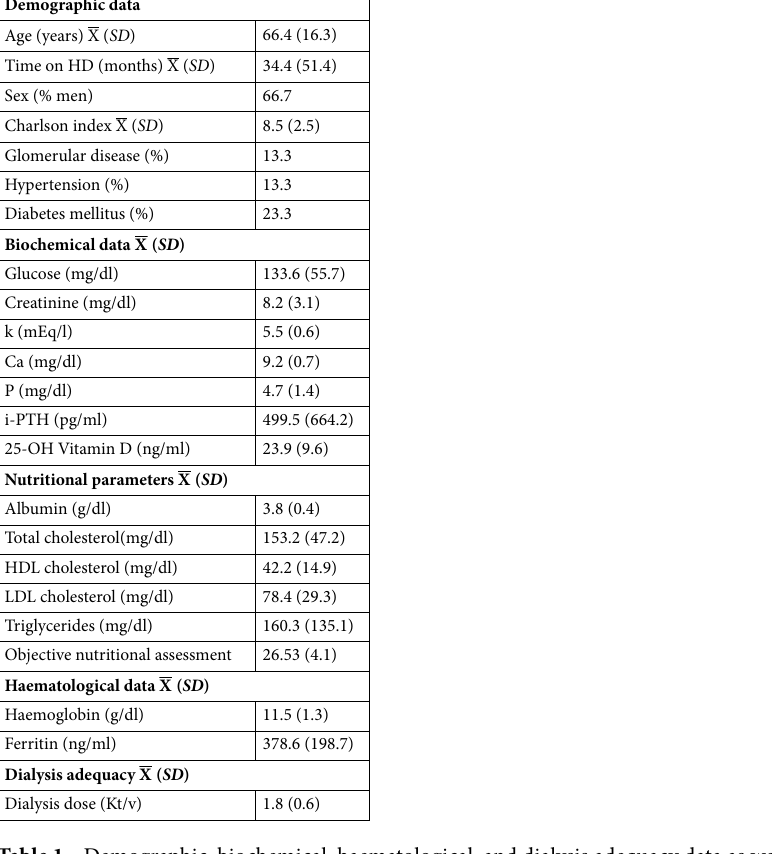
Table 1. Demographic, biochemical, haematological, and dialysis adequacy data as well as nutritional parameters for the patient cohort. N = 30. Ca calcium, HD haemodialysis, HDL high-density lipoprotein, i‑PTH intact parathyroid hormone, k potassium, kt/v Daugirdas formula for second-generation logarithmic estimates of single-pool variable volume, LDL low-density lipoprotein, P